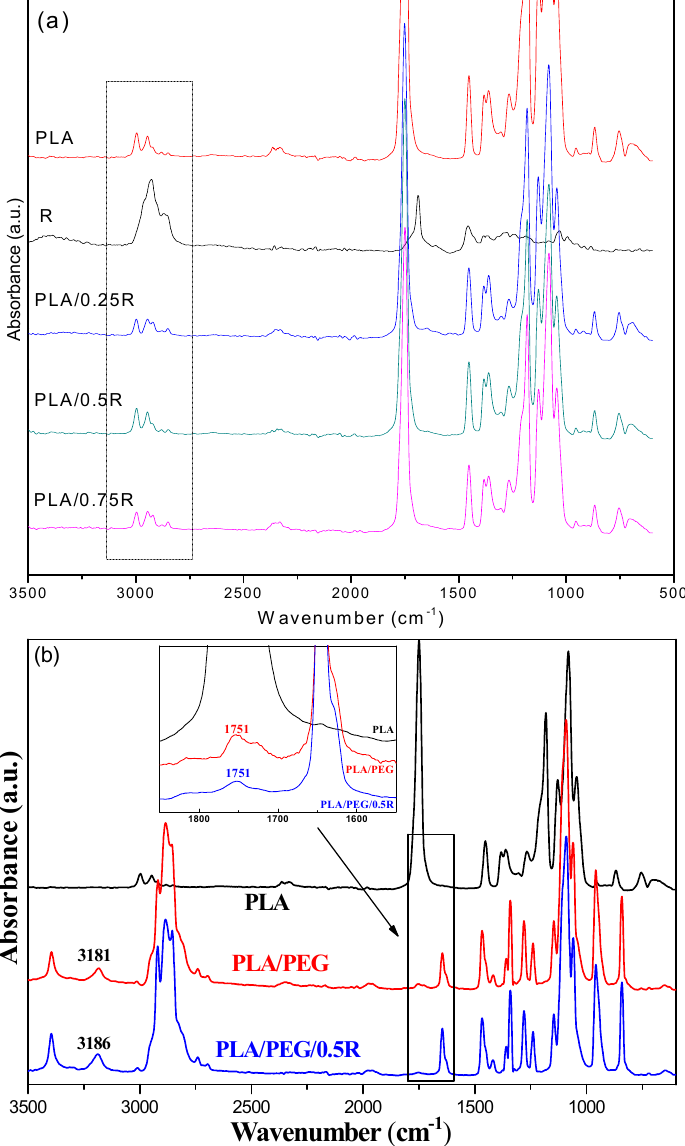
Figure 4. FTIR spectra of the neat PLA and the PLA/rosemary blends ( a ) and PLA/PEG/R ( b ); insert spectrum highlights details of different spectral regions.